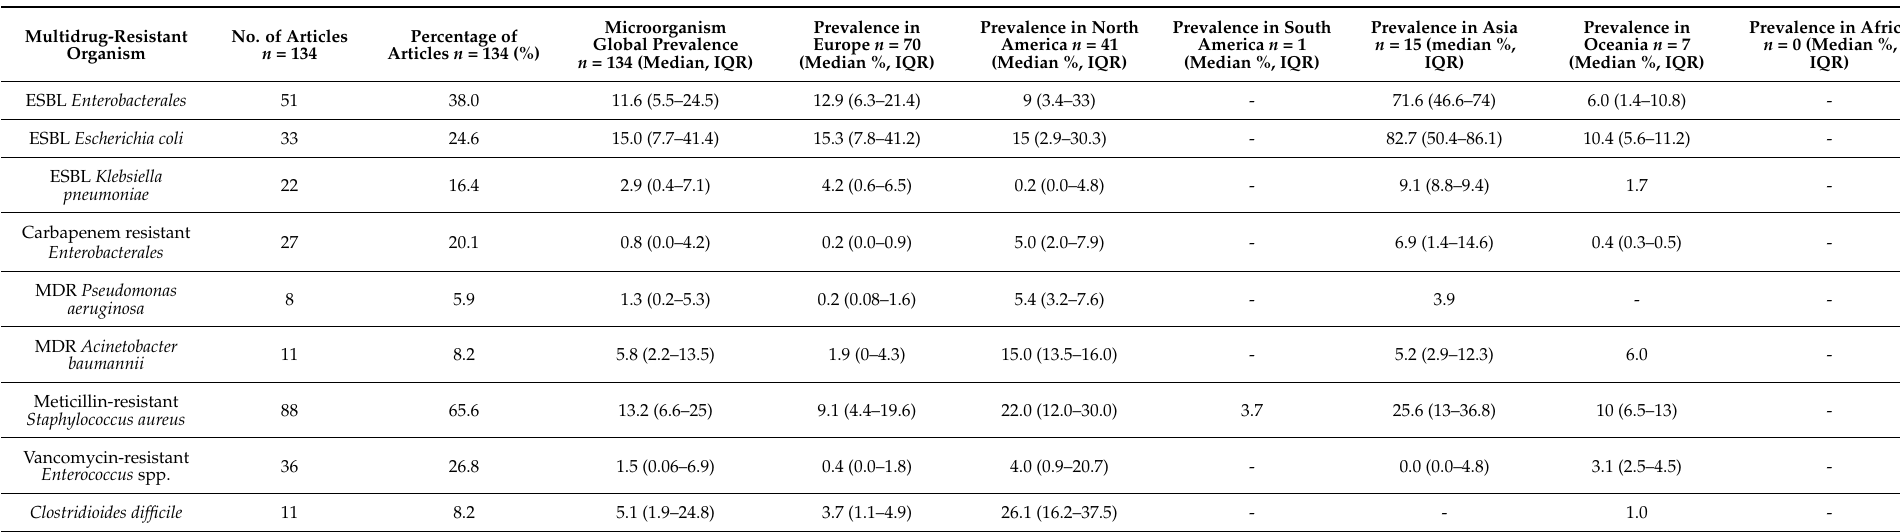
Table 1. Prevalence of multidrug-resistant organisms in long term care